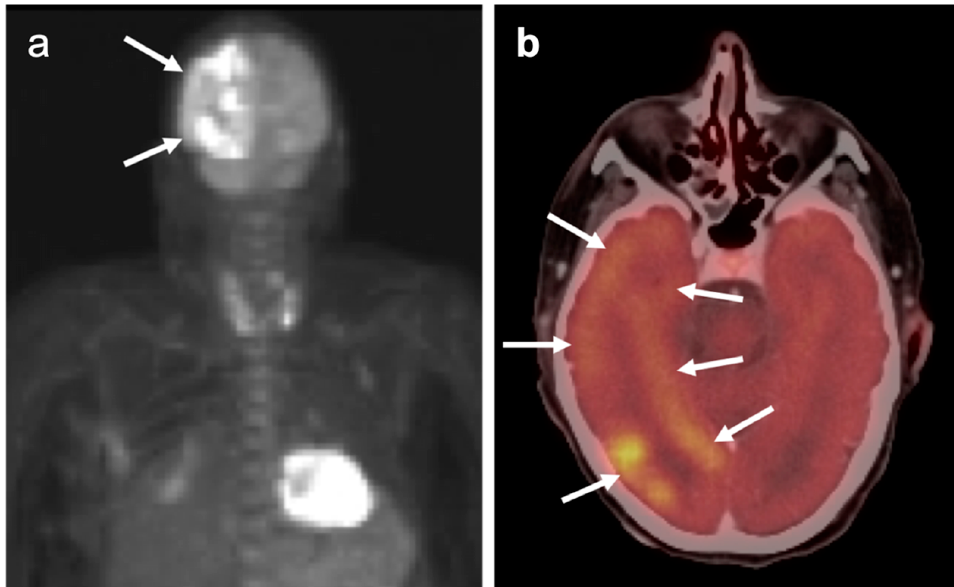
Figure 38. Active seizure on FDG PET-CT in a patient with paraneoplastic hypercalcemia. ( a ) The MIP image of an FDG PET-CT demonstrates right hemispheric hypermetabolism (white arrows) in a patient with an active seizure (the patient was sedated for the exam). ( b ) An axial PET-CT image demonstrates right hemispheric heterogeneous activity due to the seizure activity (white arrows). Active seizure activity may mimic a tumor, and MRI and conventional imaging are critical in making the correct diagnosis.